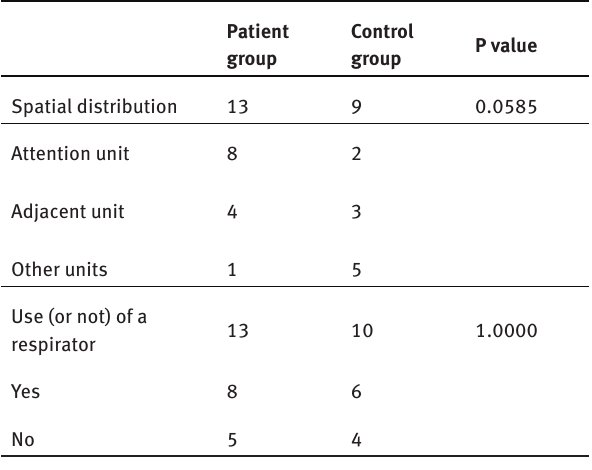
Table 2: Relationship between PDR-Ab detection, hospital unit and the use of a